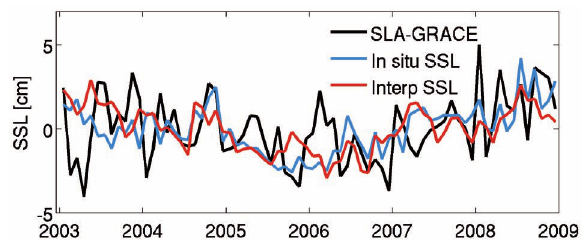
Fig. 5. – De-seasoned monthly time series of SLA minus the mass component from GRACE (black) and SSL computed from XBT/ MBT bias-corrected in situ profiles (blue) and from interpolated data (red) spatially averaged over the entire Mediterranean